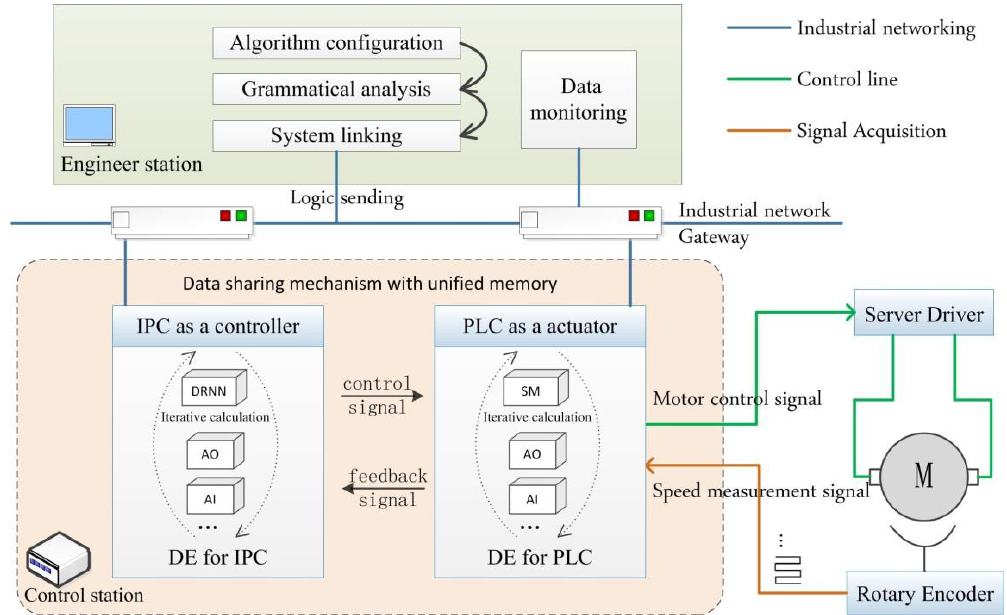
Figure 11. Block diagram of DRNN closed-loop compound control system based on DE Theory. AO: Output analog component, AI: Input analog component, SM: Speed measurement component.